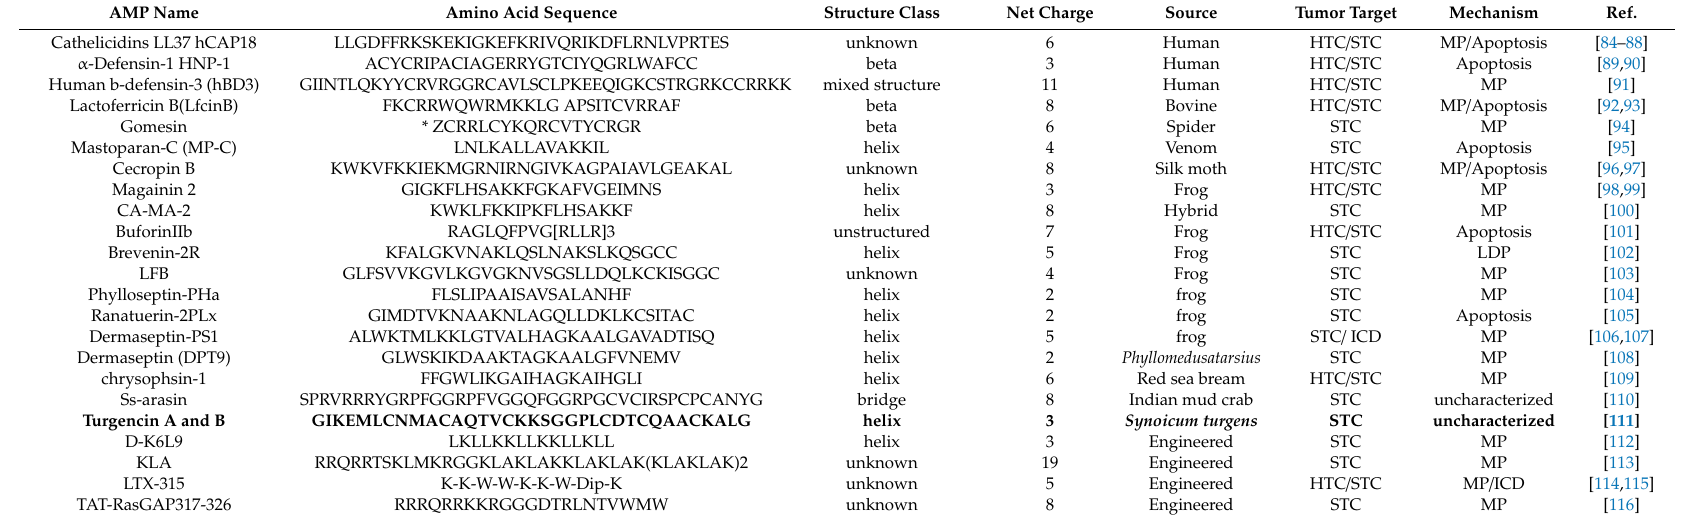
Table 1. List of the most representative antimicrobial peptides acting as anticancer